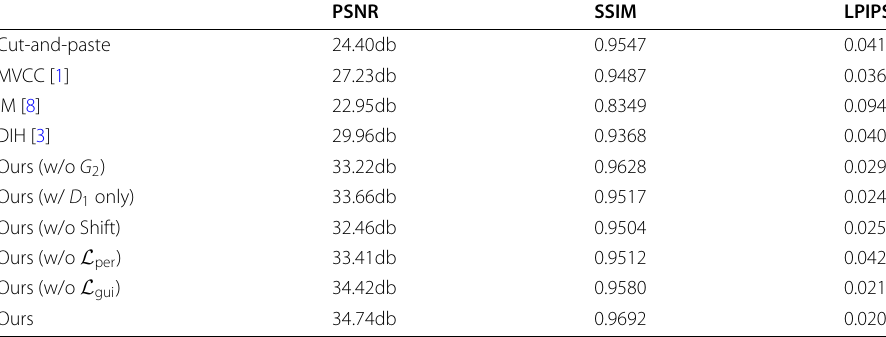
Table 3 Comparisons of methods on the FiveK test dataset PSNR SSIM LPIPS Cut-and-paste 24.40db 0.9547